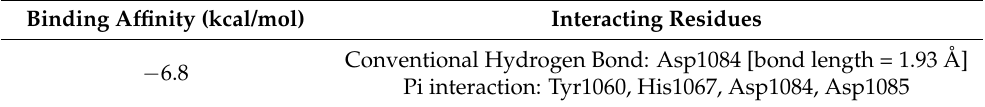
Table 2. Docking results of artonin F with USP8. Binding Affinity